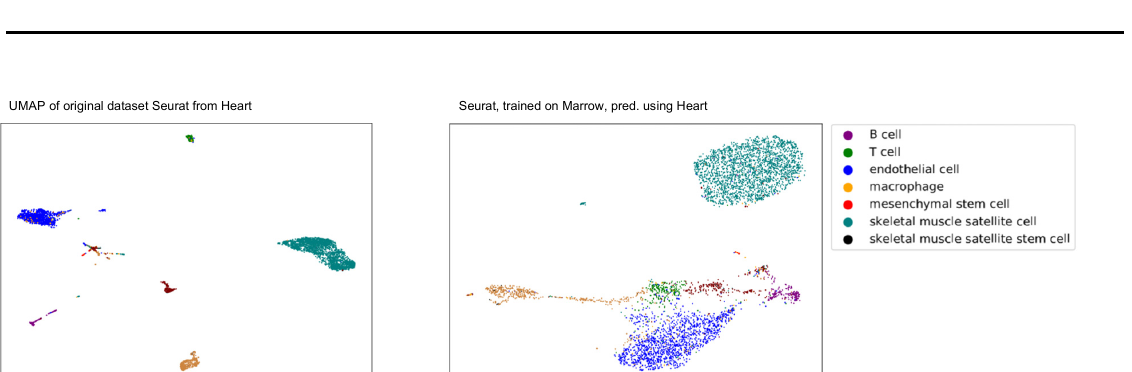
Figure 2. Left plots are the original UMAP of the Seurat datasets, Bladder, Heart, Mammary, Muscle. The right plots are the same datasets e ncoded by the model trained on the Seurat Marrow dataset. Each color depicts a different cell type, as labeled in Tabular Muris Compendium